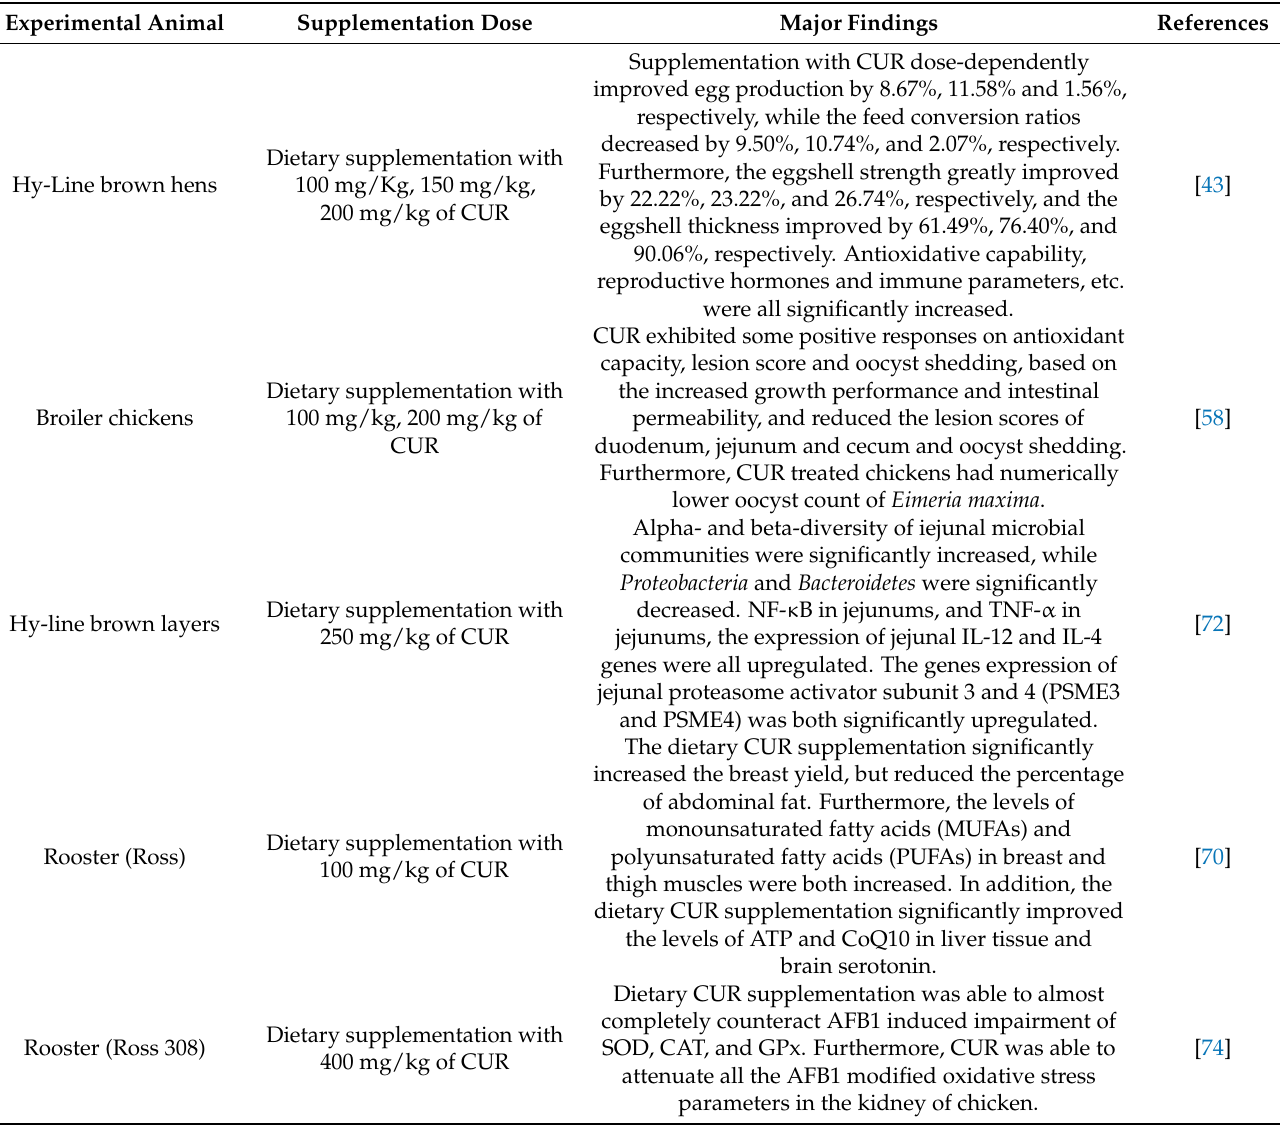
Table 2. Application effect of CUR in poultry feeding as a plant-derived feed